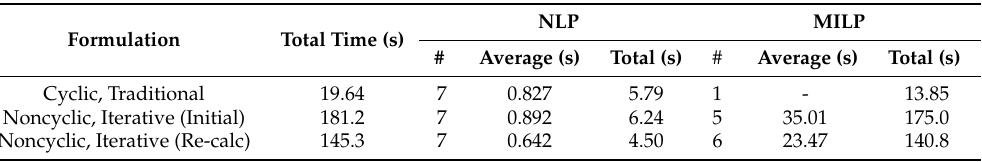
Table 29. Computational results: Scenario